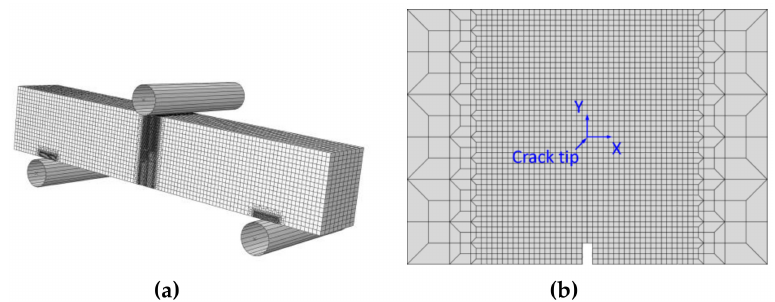
Figure 4. The whole mesh of the typical model ( a ) and the mesh in the crack growth region ( b ). The load versus load-line displacement curve can be obtained from the FEM simulation.